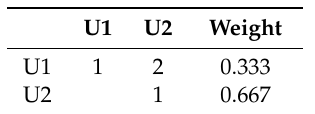
Table A4. Pairwise comparison matrix of Use indicators.